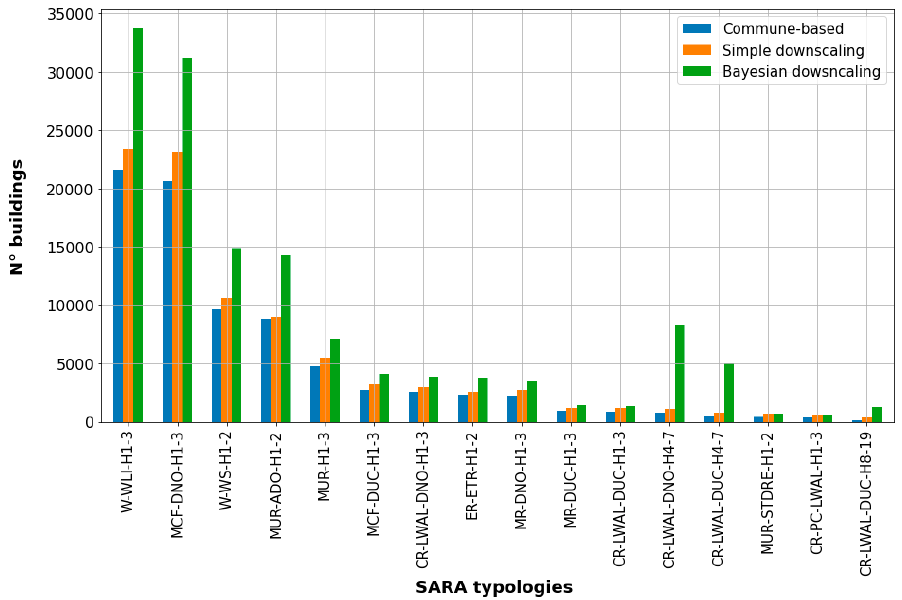
Figure 11. Comparison of the building counts per SARA typology for the three exposure models considered for Valparaíso, showing the initial commune-based model with merged classes, the pre- considered for Valpara í so, showing the initial commune-based model with merged classes, the liminary model (simple downscaling), and the Bayesian model. preliminary model (simple downscaling), and the Bayesian